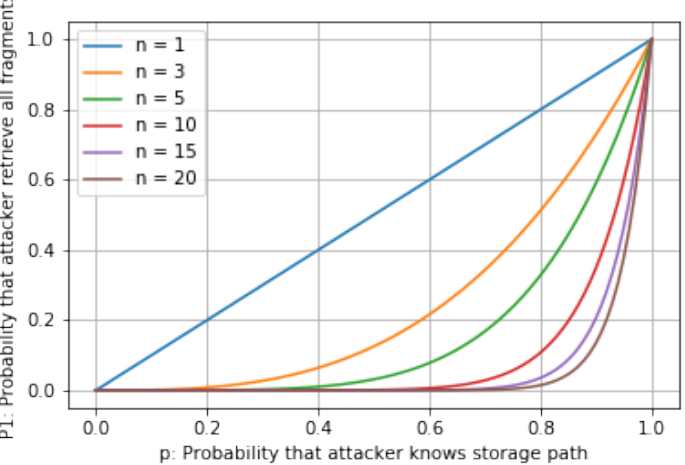
Figure 6. Probability that an attacker retrieves all fragments when the storage path is